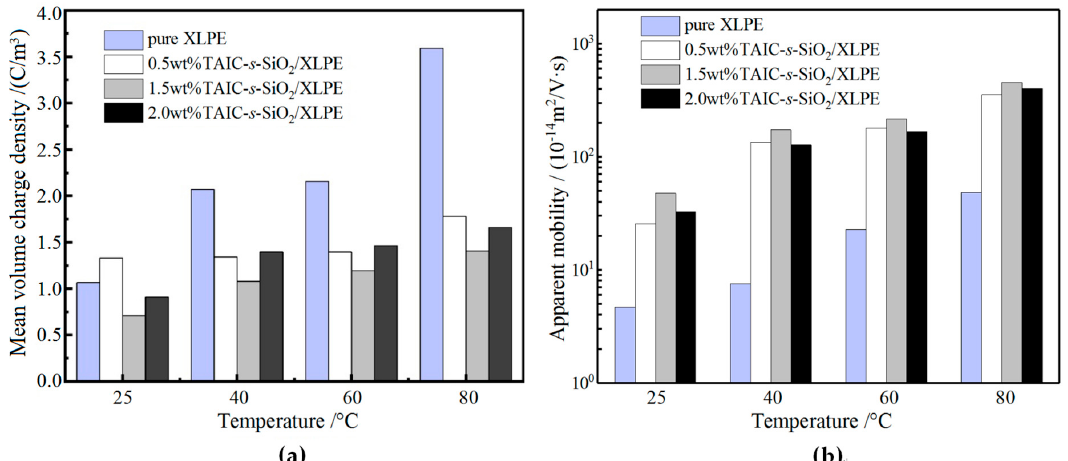
Figure 12. ( a ) Mean volume density of space charges under DC electric field of 40 kV/mm for 3600 s polarization time; ( b ) apparent mobility of space charges at the beginning of depolarization progress in short circuit after 3600 s polarization.